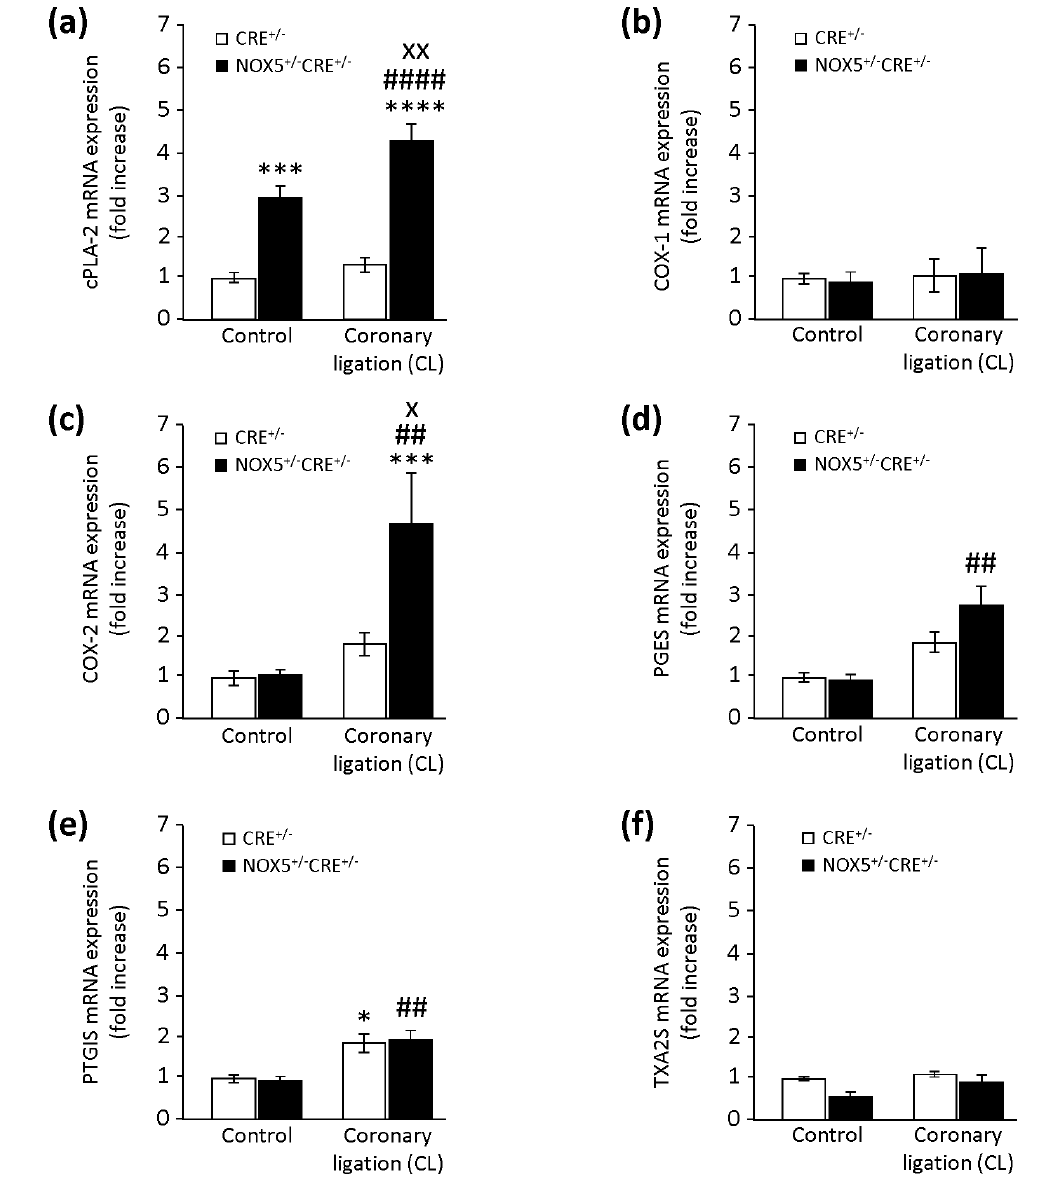
Figure 7. Quantification of enzymes involved in cardiac PG biosynthesis. ( a ) cPLA-2 mRNA expression in control and infarcted mice. *** p < 0.001 vs. CRE +/ − , **** p < 0.0001 vs. CRE +/ − , #### p < 0.0001 vs. CRE +/ − CL, and xx p < 0.01 vs. NOX5 +/ − CRE +/ − . ( b ) COX-1 mRNA expression in control and infarcted mice. ( c ) COX-2 mRNA expression in control and infarcted mice. *** p < 0.001 vs. CRE +/ − , ## p < 0.01 vs. CRE +/ − CL, and x p < 0.05 vs. NOX5 +/ − CRE +/ − . ( d ) PGES mRNA expression in control and infarcted mice. ## p < 0.01 vs. NOX5 +/ − CRE +/ − . ( e ) PGI 2 synthase (PTGIS) mRNA expression in control and infarcted mice. * p < 0.05 vs. CRE +/ − , and ## p < 0.01 vs. NOX5 +/ − CRE +/ − . ( f ) Thromboxane A2 synthase (TXA2S) mRNA expression in control and infarcted mice. Control, control mice with no MI. Coronary ligation (CL), mice that suffered MI by LAD coronary ligation. CRE +/ − , mice with the CRE +/ − genotype ( n = 9 for CRE +/ − and NOX5 +/ − CRE +/ − groups). NOX5 +/ − CRE +/ − mice with the NOX5 +/ − CRE +/ − genotype ( n = 12 for the CRE +/ − CL group, and n = 13 for the NOX5 +/ − CRE +/ − CL group).